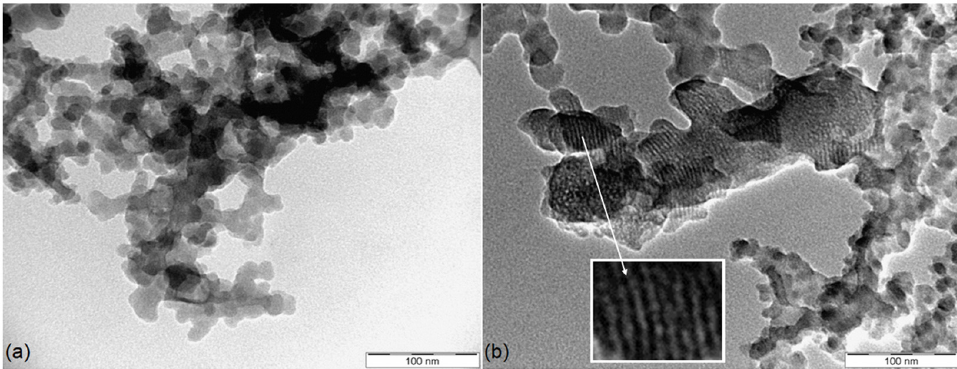
Figure 6. TEM images of ( a ) SnP@SiO 2 and ( b ) SnP@MCM − 41 . The inset represents an enlarged image of regular arrays of cylindrical mesopores.